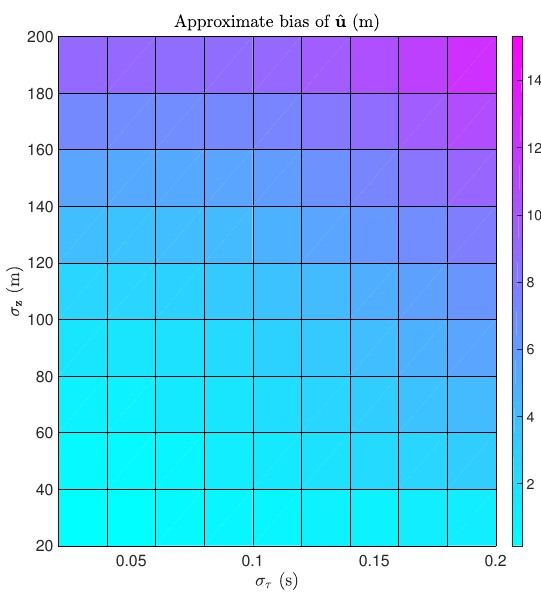
Figure 5. Surface plot of norm of the approximate bias of ˆ u .